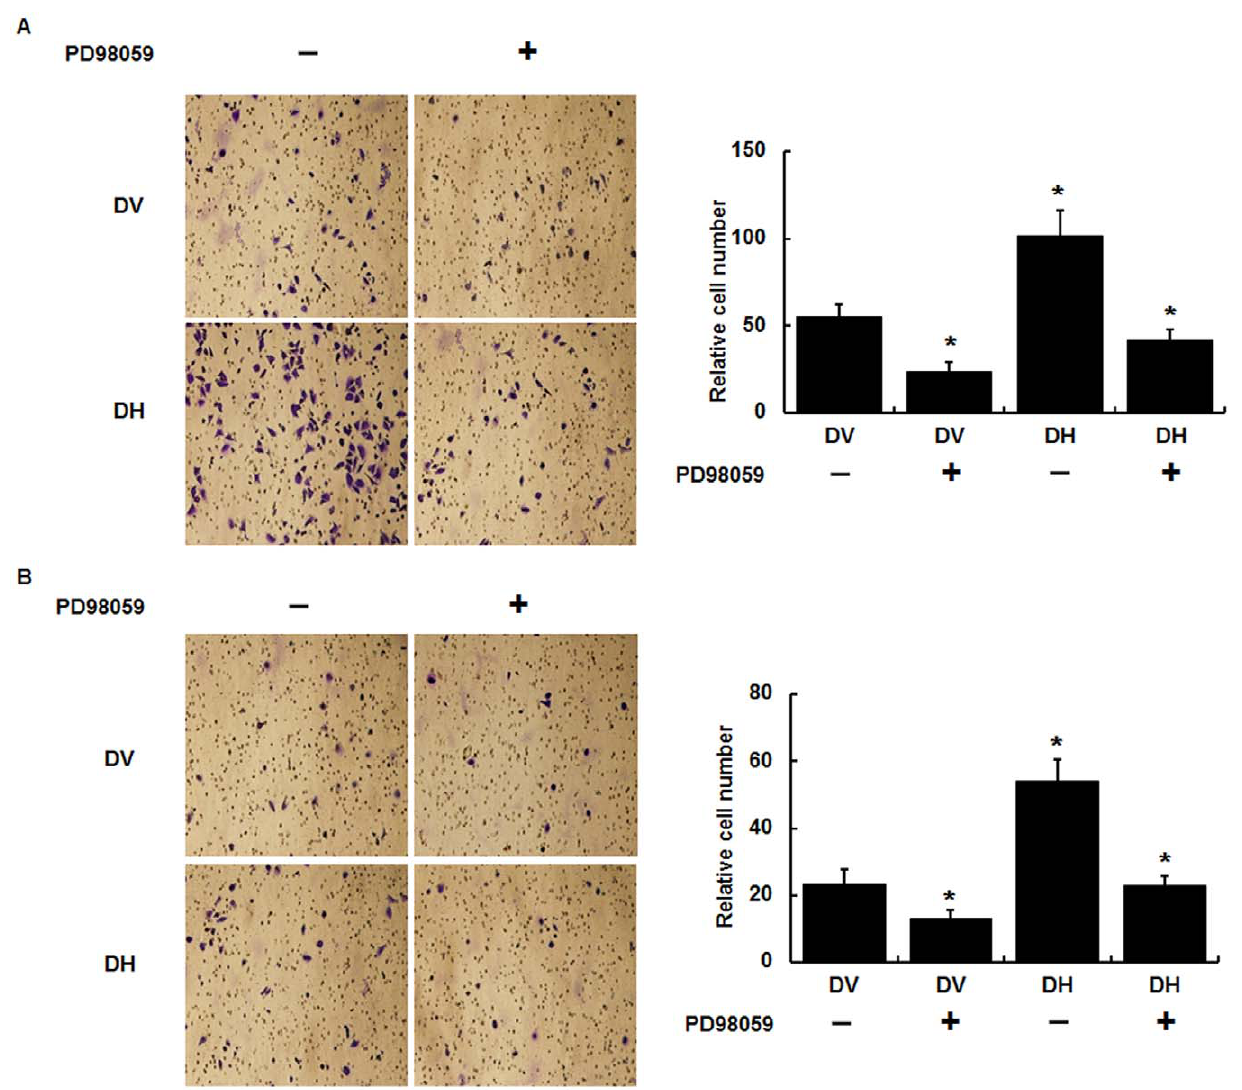
Figure 6. HCG b promotes cell migration and invasion. (A) We seeded 1 6 10 5 cells in a 24-well plate with cell inserts, the cells were added with/ without PD98059(25 m M) for 6 h to detect cell migration, the results showed that hCG b promotes cell migration significantly versus control. (B) In the same conditions we incubated the cells in the invasion chamber with artificial basement membrane, the cells were added with/without PD98059(25 m M) for 12 h to detect cell invasion, the results showed that hCG b promotes cell invasion significantly. All procedures were performed as described in Methods. *, indicates P , 0.05 versus control. Data were shown as means 6 SEM from three separate tests.